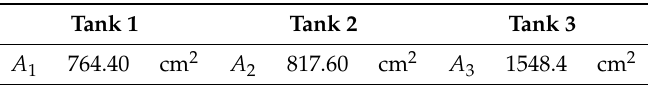
Table 1. Tanks’ constant parameters.